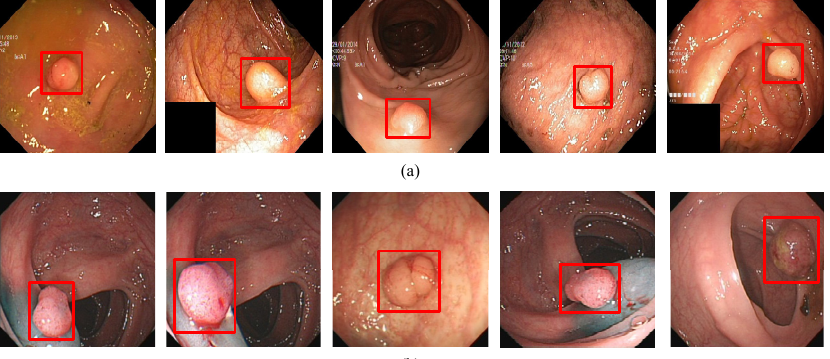
Figure 6. ( a ) A subset of the detection results of single polyp in Kvasir-SEG data set. ( b ) A subset of the detection results of single polyp in WCY data set. The red squares in the figure are the bounding boxes of the polyps.